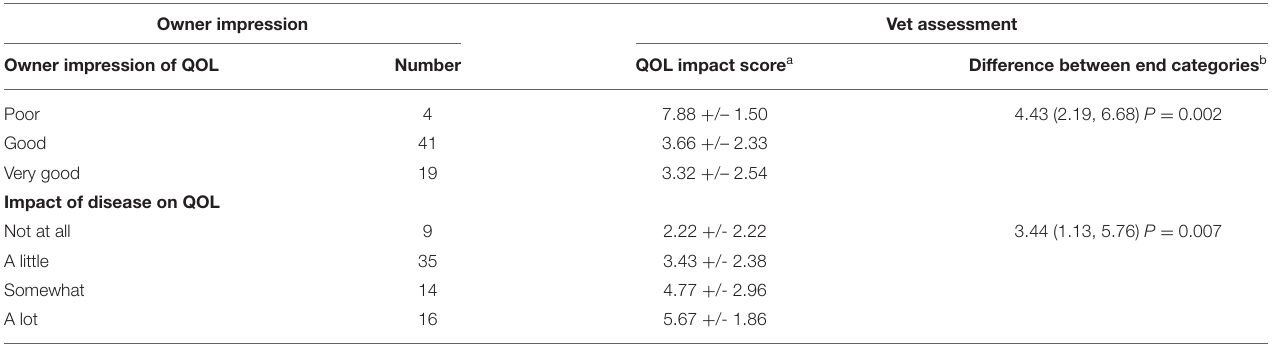
TABLE 6 | Comparison of quality of life (QOL) impact score in the vet assessment and owner impressions of their cat’s